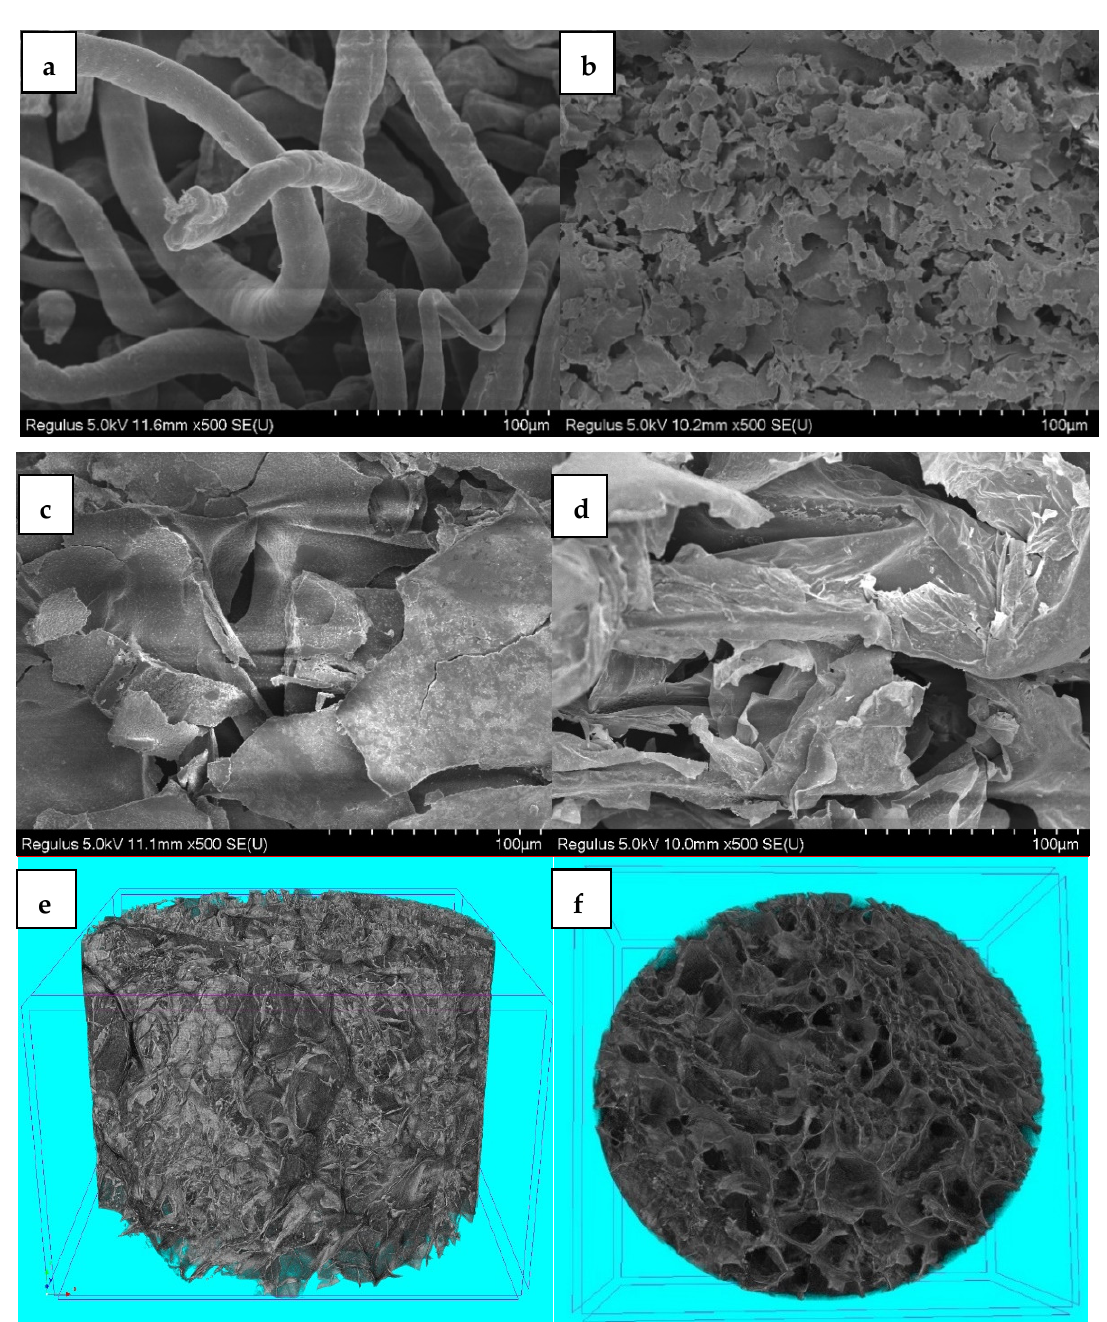
Figure 3. SEM images of ( a ) CMC and ( b ) PNIPAM, ( c ) CMC/PNIPAM, and ( d ) CMC/Ca 2+ /PNIPAM aerogels; Micro-CT stereogram ( e ) and cross section ( f ) of CMC/Ca 2+ /PNIPAM aerogels.